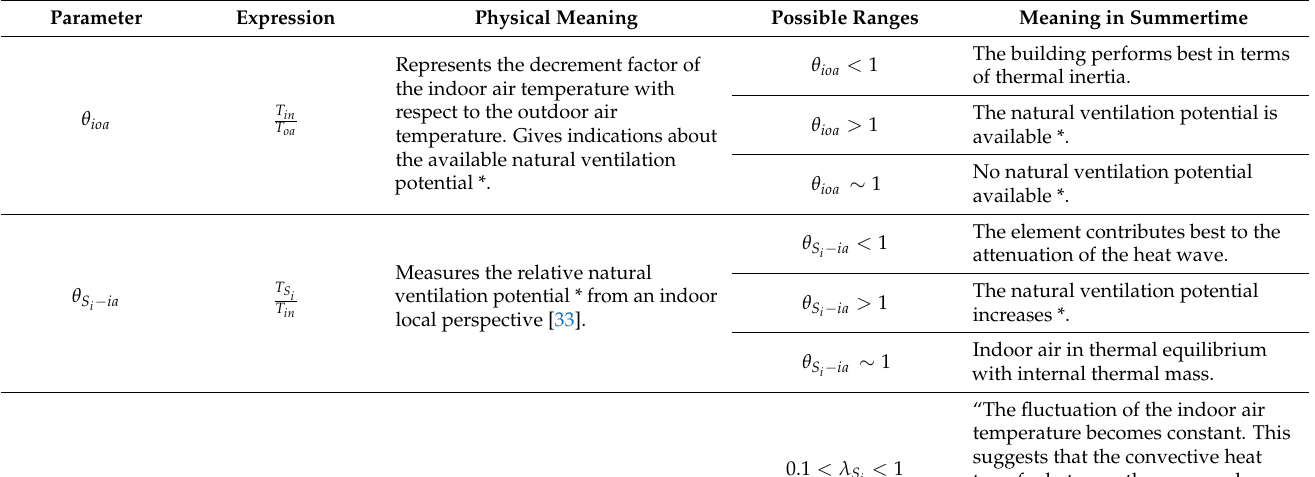
Table 4. Variables and their physical meanings for the parametric